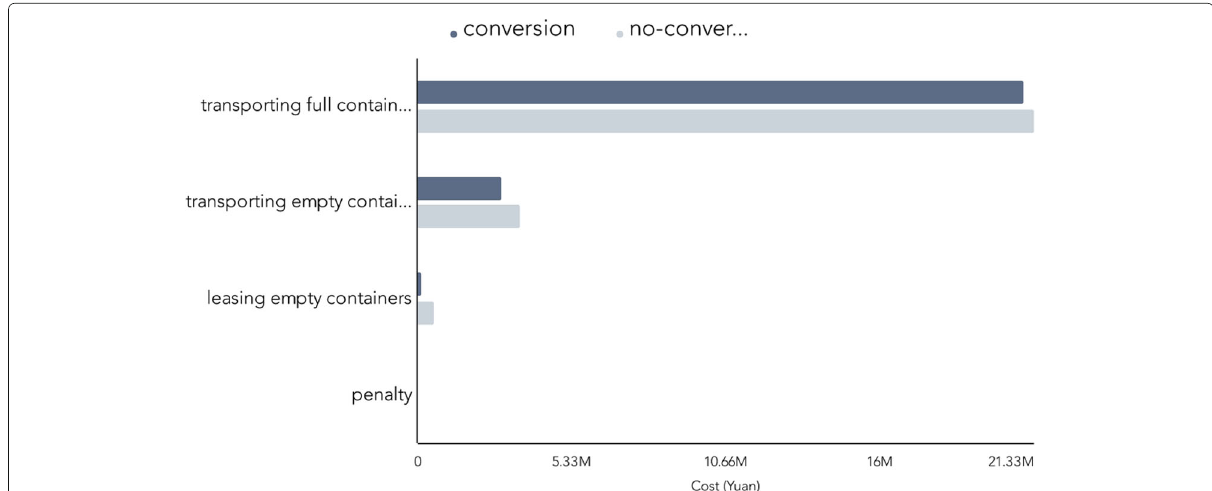
Fig. 7 Operating costs whether consider conversion of containers or